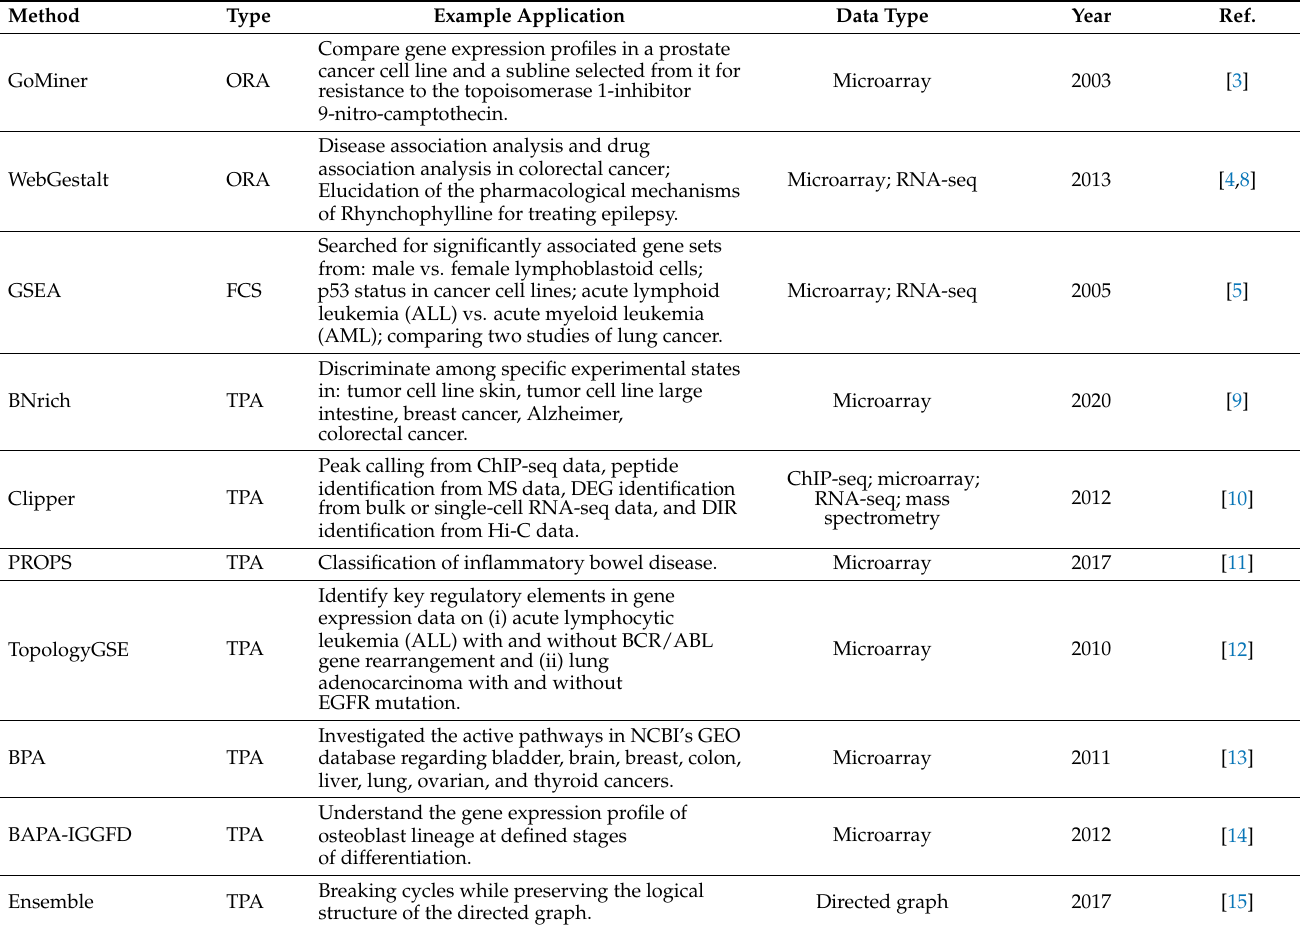
Table 1. Summary of representative PEA approaches and their